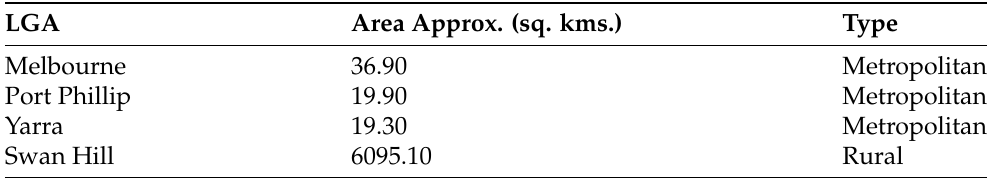
Table 6. Details of LGAs used in ablative study of